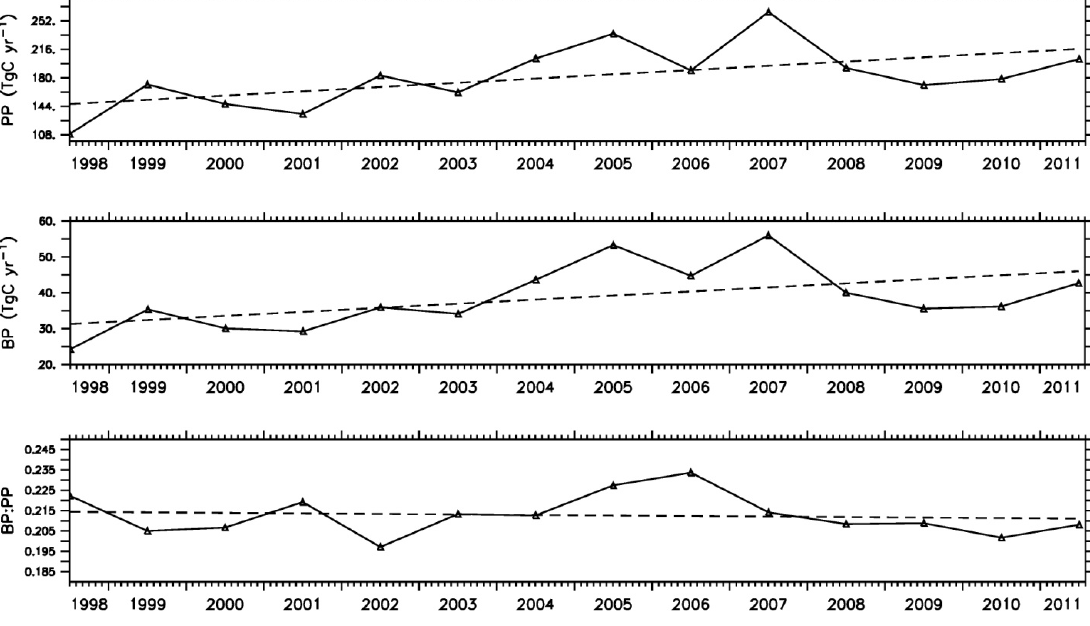
Figure 5. Time course of primary production (PP,TgCyr − 1 ) (top panel), bacterioplankton production (BP,TgCyr − 1 ) (middle panel), and the BP:PP ratio in the ice-free shelves (see text for details) of the Arctic Ocean domain (>66.5 ◦ N) simulated in the RIV run. The dashed straight lines represent the linear trend computed over the 1998–2011